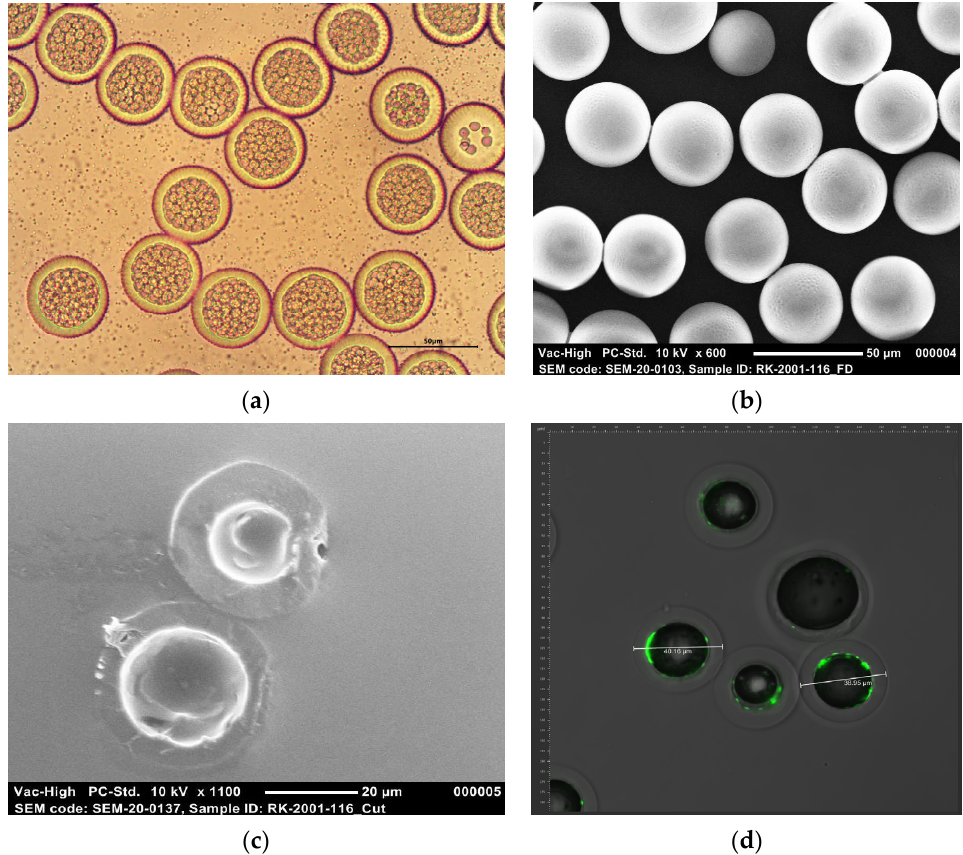
Figure 3. Representative microscopy images of PDLG5002-based core–shell microspheres loaded with 0.9 wt % fluorescein isothiocyanate (FITC) labeled–BSA (Formulation G): ( a ) Optical microscopy image at 400 × magnification; ( b ) SEM image at 600 × magnification; ( c ) SEM image of cross-sectioned microspheres at 1100 × magnification; ( d ) overlay of an optical microscopy image and a confocal laser scanning microscopy (CLSM) image showing the distribution of the green fluorescent FITC–BSA.